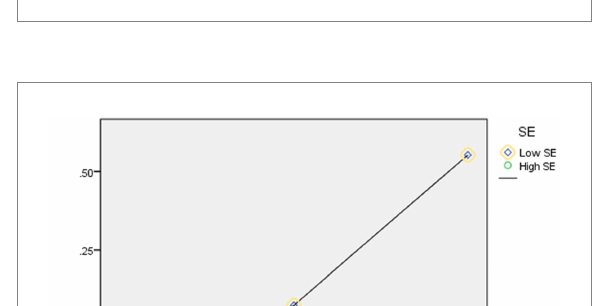
FIGURE 2 Moderation effect of self-esteem between alexithymia and PTSD. High and low levels of self-esteem represent one standard deviation above and below the mean. SE, self-esteem; PTSD, posttraumatic stress disorder.